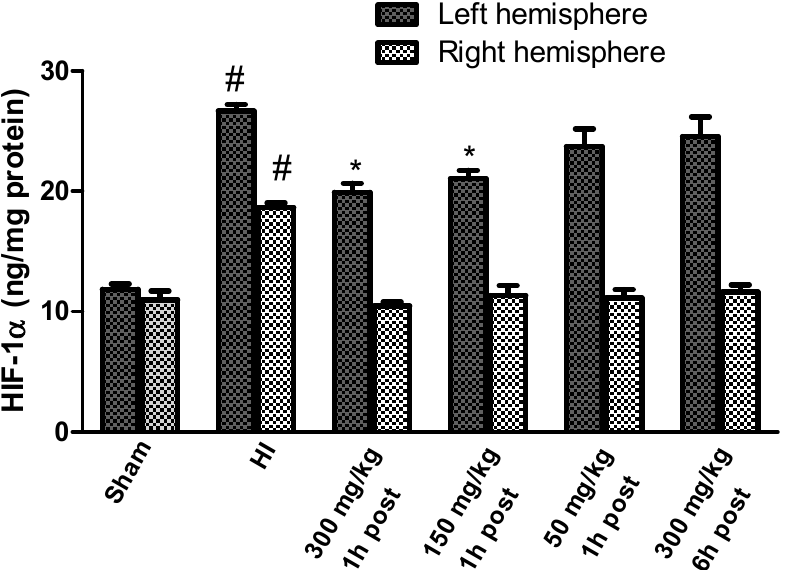
Figure 8. Effect of KYNA application on HI-induced changes in the HIF-1 α concentration. The results are presented as the means ± SEM, n = 6; statistically significant differences: * p < 0.001, compared to the HI group; # p < 0.001 compared to the sham-operated group.